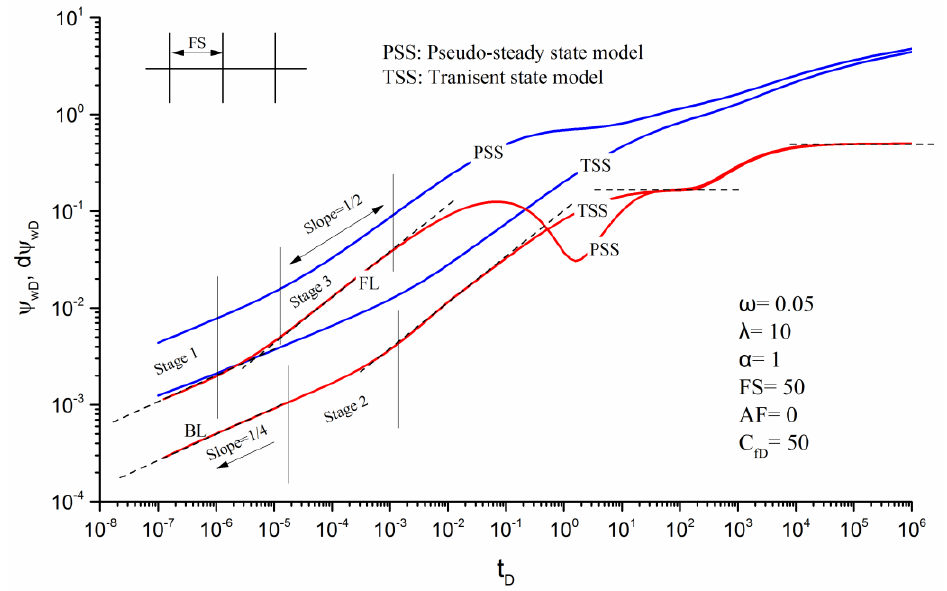
Figure 6. Comparison of the typical pseudo-pressure curves for a multi-fractured horizontal well between pseudo-steady state (PSS) and transient state (TSS) models.